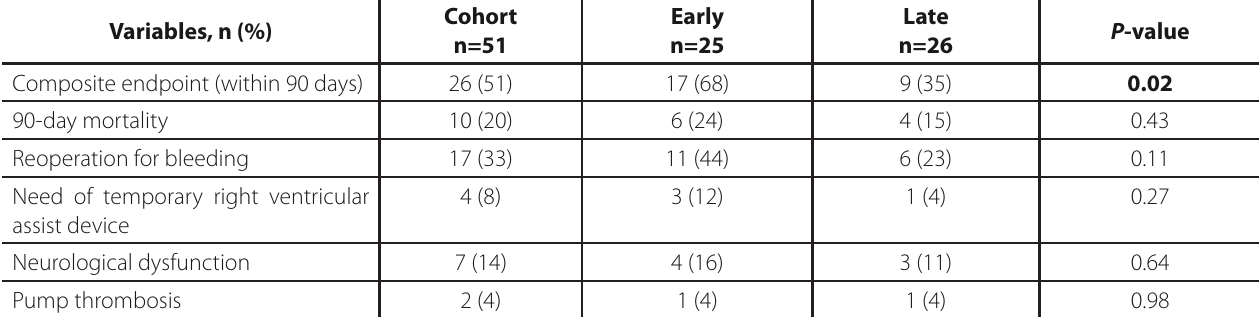
Table 3. Composite endpoint and outcomes at follow-up in the early (2009 to 2014) and late (2015 to 2017) groups of HeartMate II implantation.